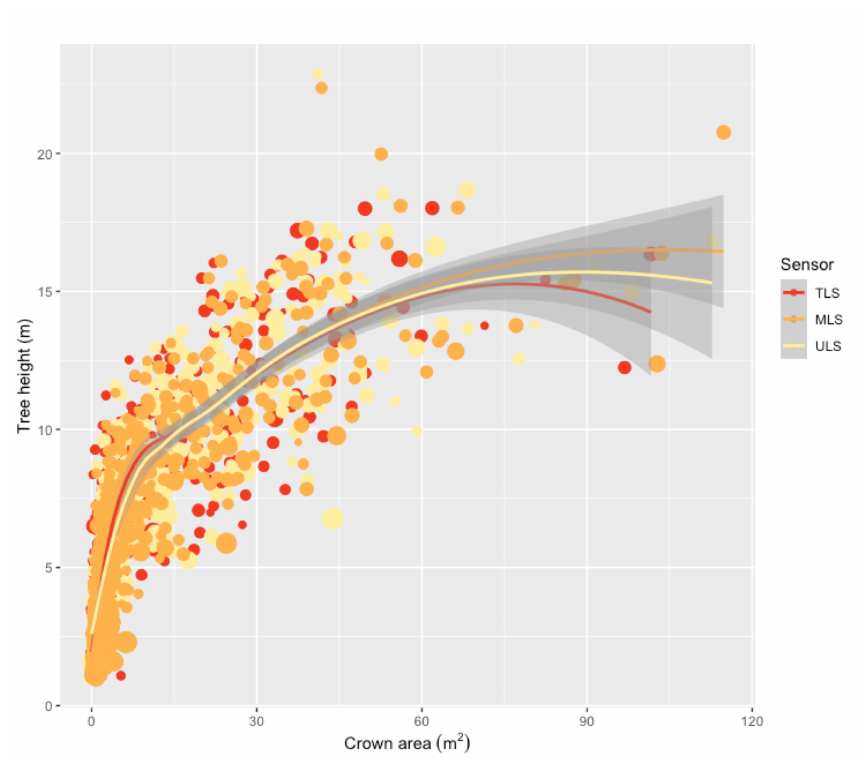
Figure 12. Relationship between individual tree height and crown area, as determined from the three different LiDAR